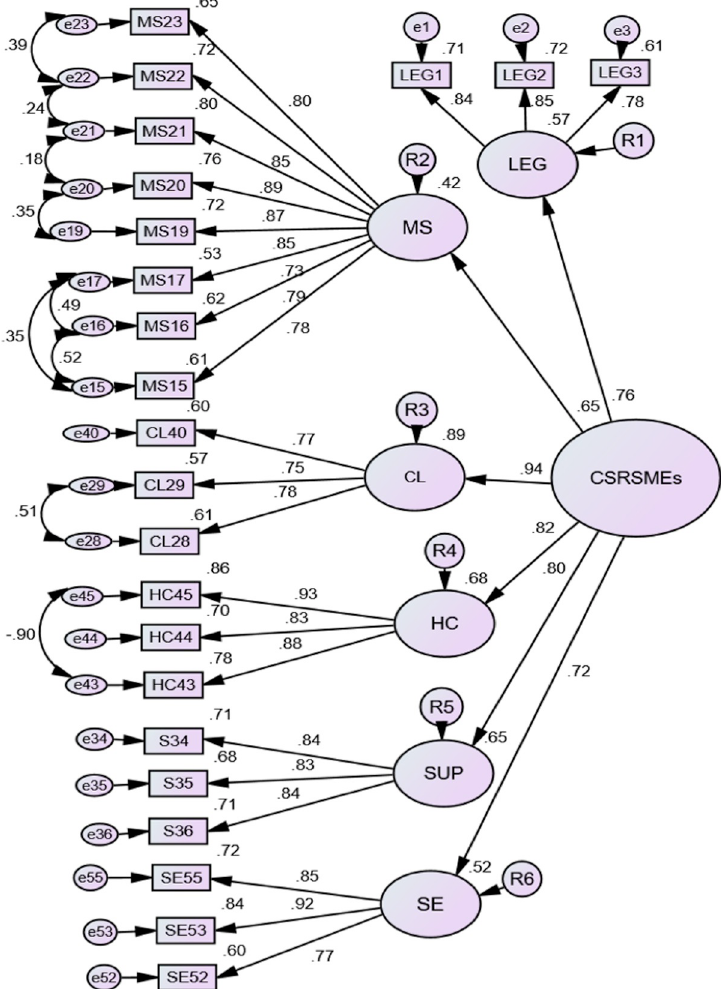
Fig 1. Confirmatory factor analysis of the CSRSMEs model. Notes: Chi-square = 333.900; Probability level=0.000; Degrees of freedom=206; Chi-square normed=1.621. RMSEA = 0.054 LO 90 = 0.043 p=0.243; CFI=0.968; PCFI=0.788; NFI=0.922; PNFI=0.751; TLI=0.961. Source: Own elaboration.